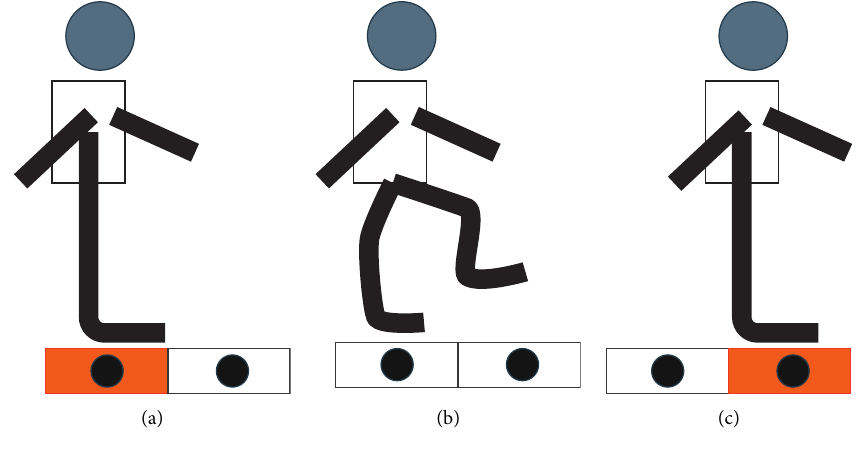
Figure 8: Gait movement